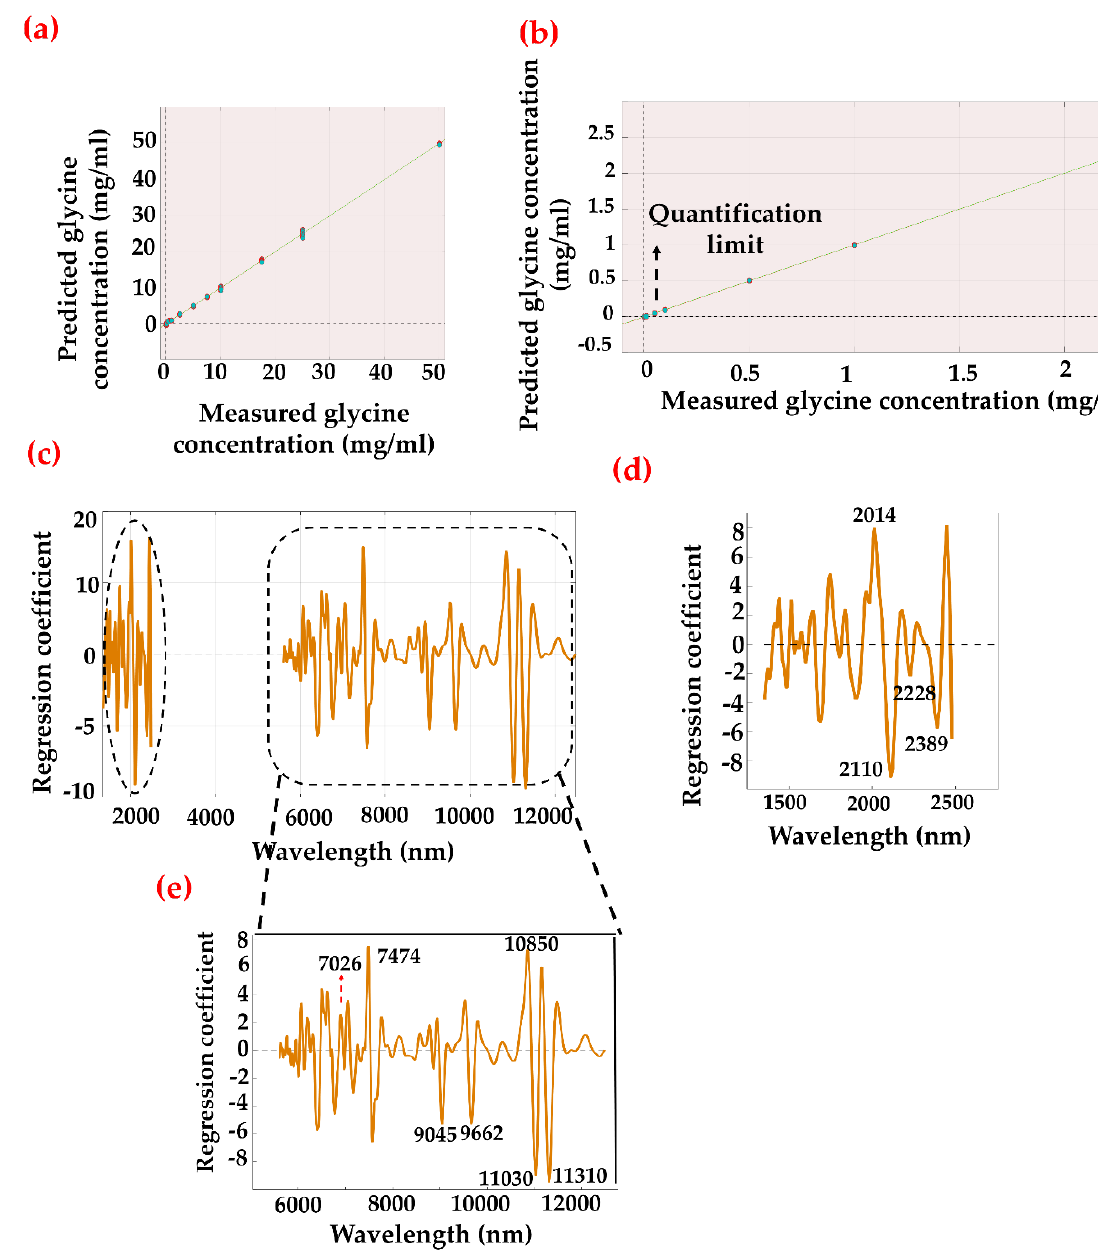
Figure 4. PLS-R predicted model of glycine-spiked serum samples. ( a ) Regression plot of entire range between 0 (control) and 50 mg/mL region. ( b ) Extrapolated and remodeled 0–2.5 mg/mL region. ( c ) Corresponding regression coefficient/vector over hetero-spectral region covering NIR (2500– 1350 nm) and MIR (12,500–5555 nm). ( d ) Magnified view of regression vector over 2500–1350 nm and ( e ) 12,500 – 5555 nm region. Table 1. Summary of regression statistics .